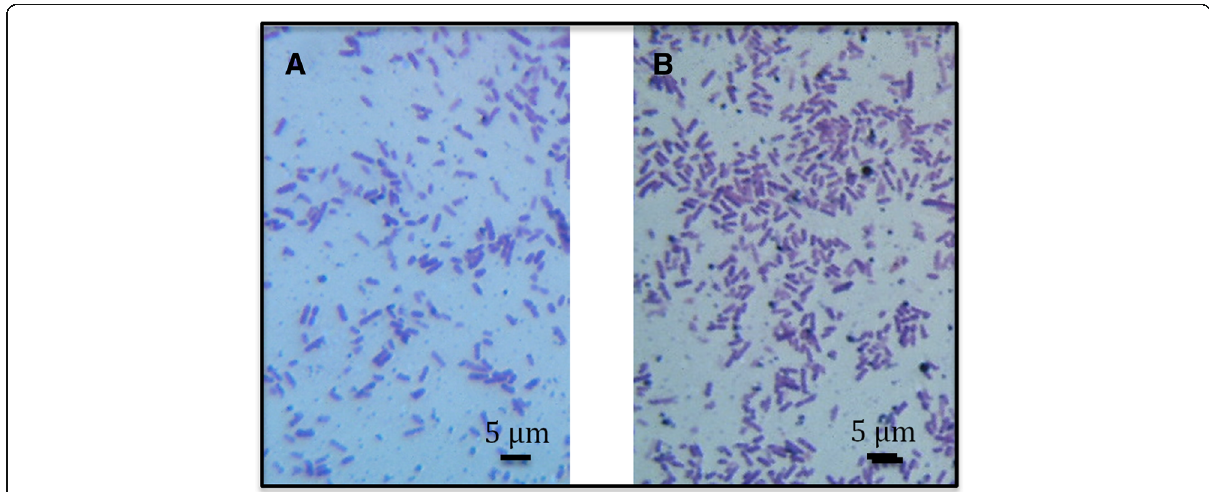
Fig. 1 Photomicrographs of Gram stained exponentially growing “ P. peruviense ” cells. ( a ) strain A97-S13-F16, ( b ) A350-S18-N16. A light microscope with 100X magnification was used. These photomicrographs show the rod shaped forms of both strains. The bar scale represent 5 μ